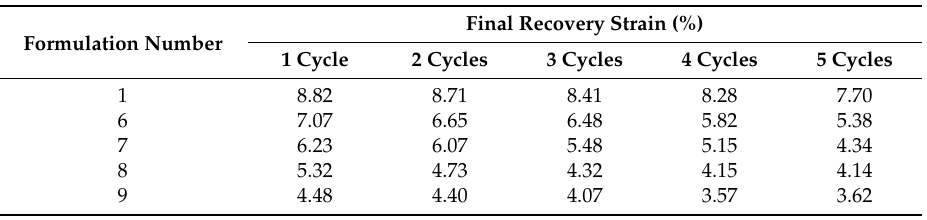
Table 7. Cyclic tensile response curves for five cycles at deformation (100%) of polyurethane coatings.